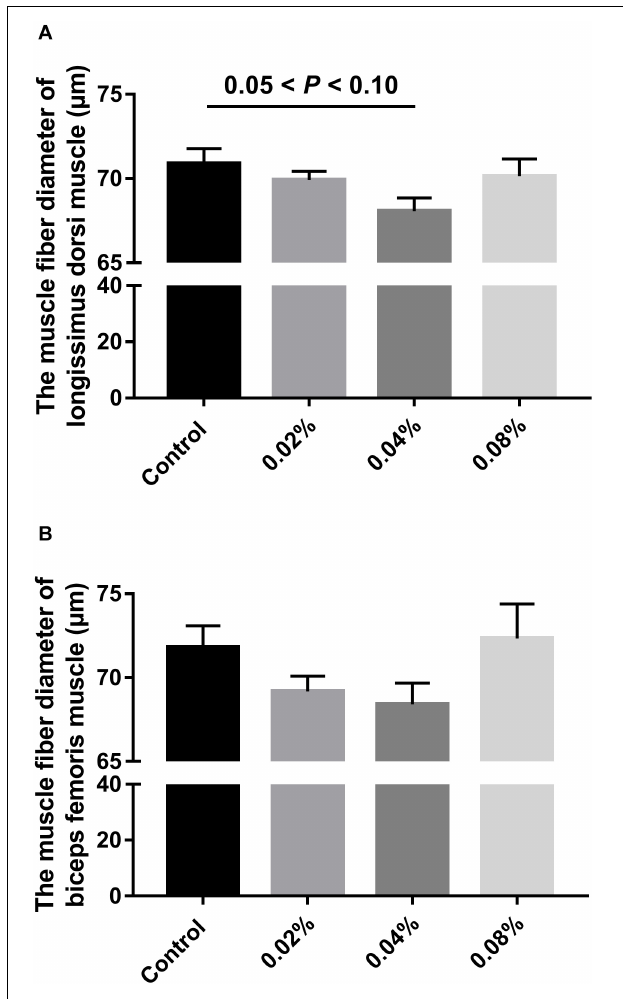
FIGURE 2 | Effects of different levels of dietary CGA supplementation on muscle fiber diameter of finishing pigs. (A) The muscle fiber diameter of LD muscle. (B) The muscle fiber diameter of BF muscle. Values are means, with their standard errors represented by vertical